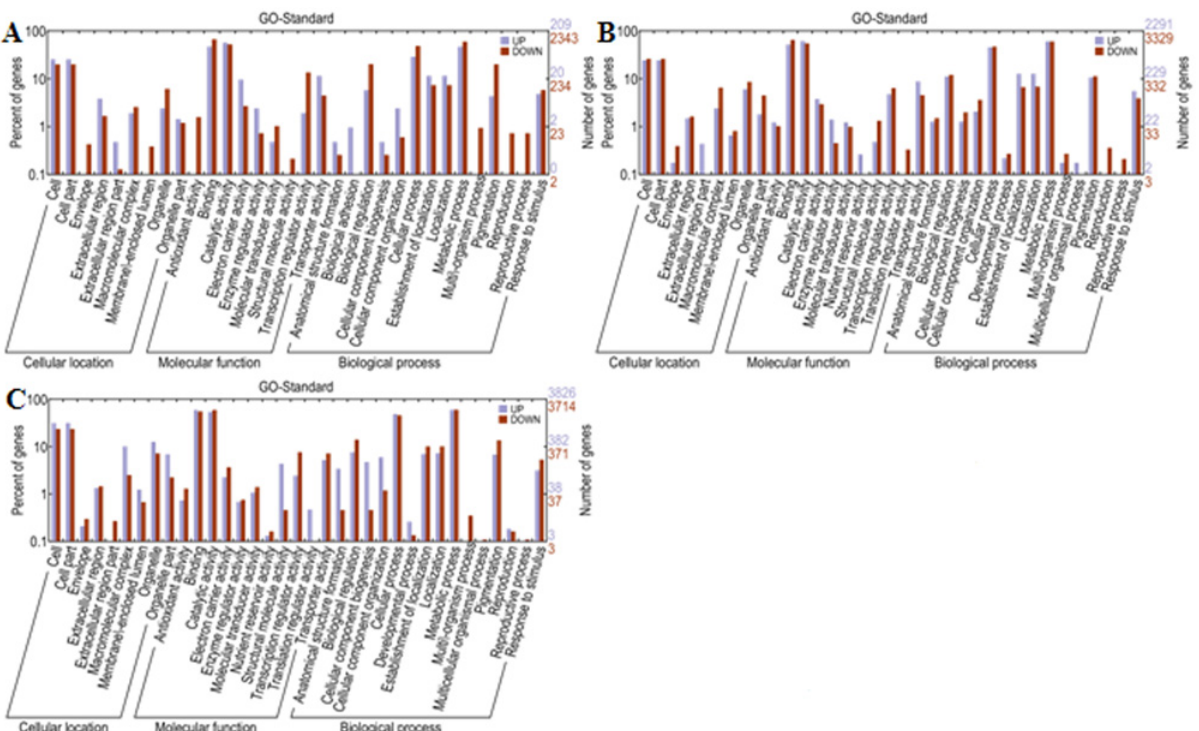
Fig 7. GO functional classification of the control and salt treatment seedlings. A. The comparison between S1(2h)and CK. B. The comparison between S2(12h) and CK. C. The comparison between S1 and S2.